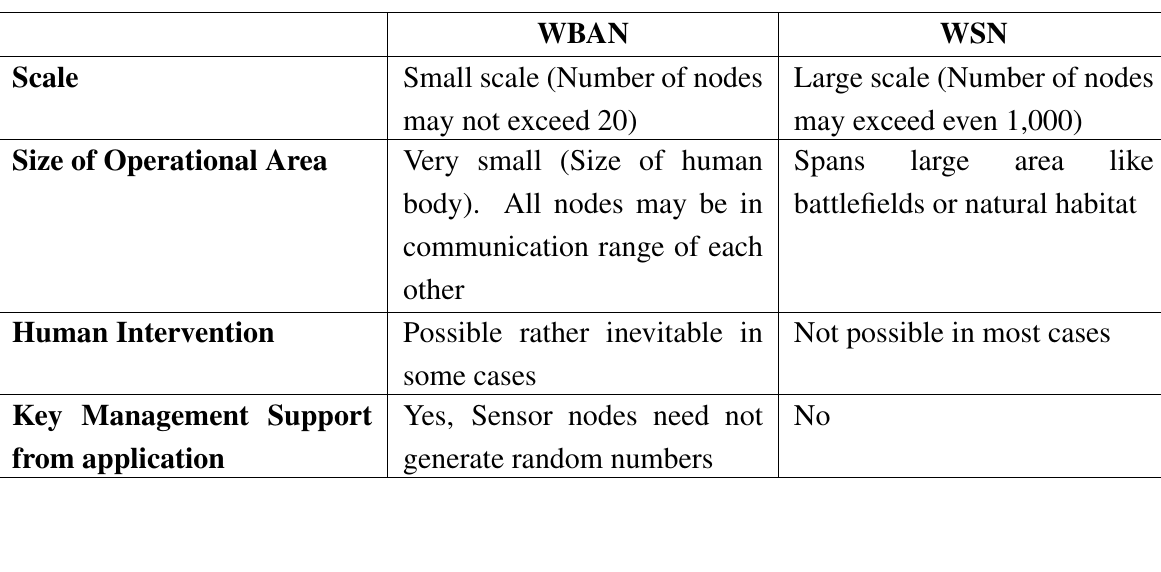
Table 2. Differences between the security requirements of WBAN and